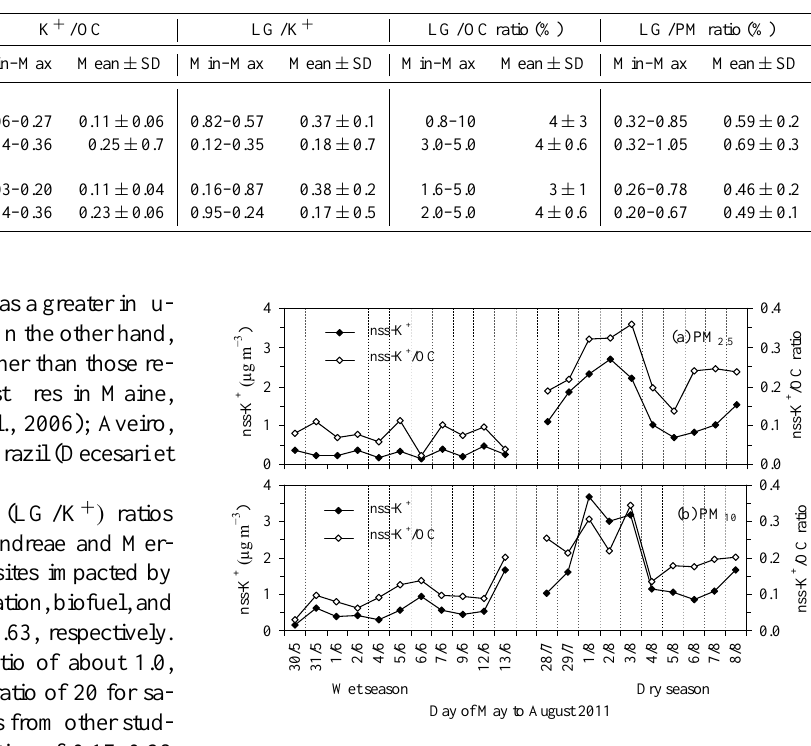
Fig. 9. Temporal variations of nss-K + and nss-K + /OC ratios in PM 2 . 5 and PM 10 during the wet and dry